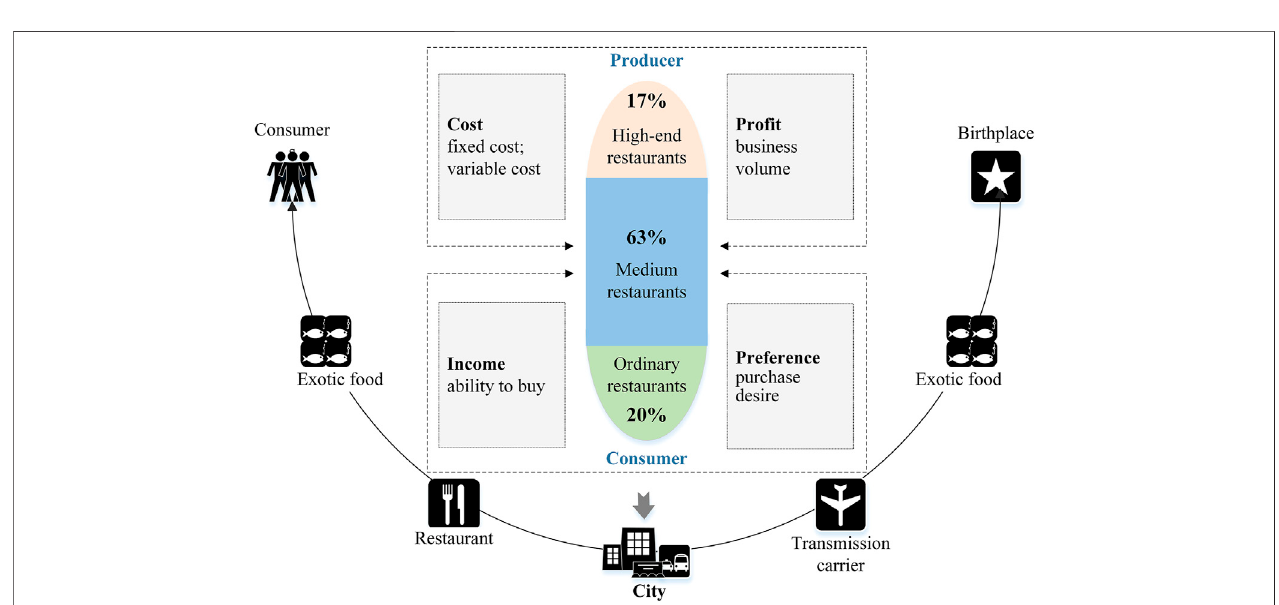
FIGURE 2 | Price characteristics of Japanese cuisine in